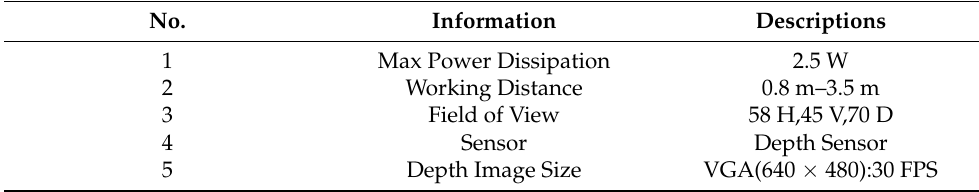
Figure 7. The vehicle with the RGB-D camera. Table 3. The specific parameters of the “LETV Pro Xtion” camera.